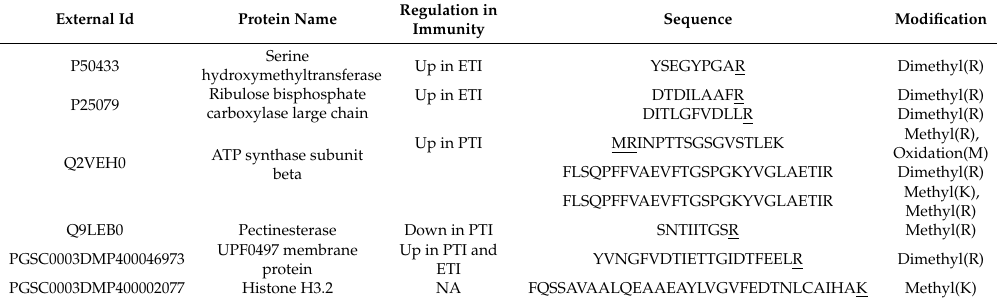
Table 5. Examples of methylated peptides identified in the analysis (all methylated peptides are shown in the supplementary material 1. Regulation in immunity: whether the protein was identified as regulated in the quantitative analysis. Sequence: The sequence of the modified peptide, underlined is the methylated site. The position and nature of the modified amino acid are indicated by a number. In the cases where a methylated peptide has been identified but the site not determined, this is indicated by